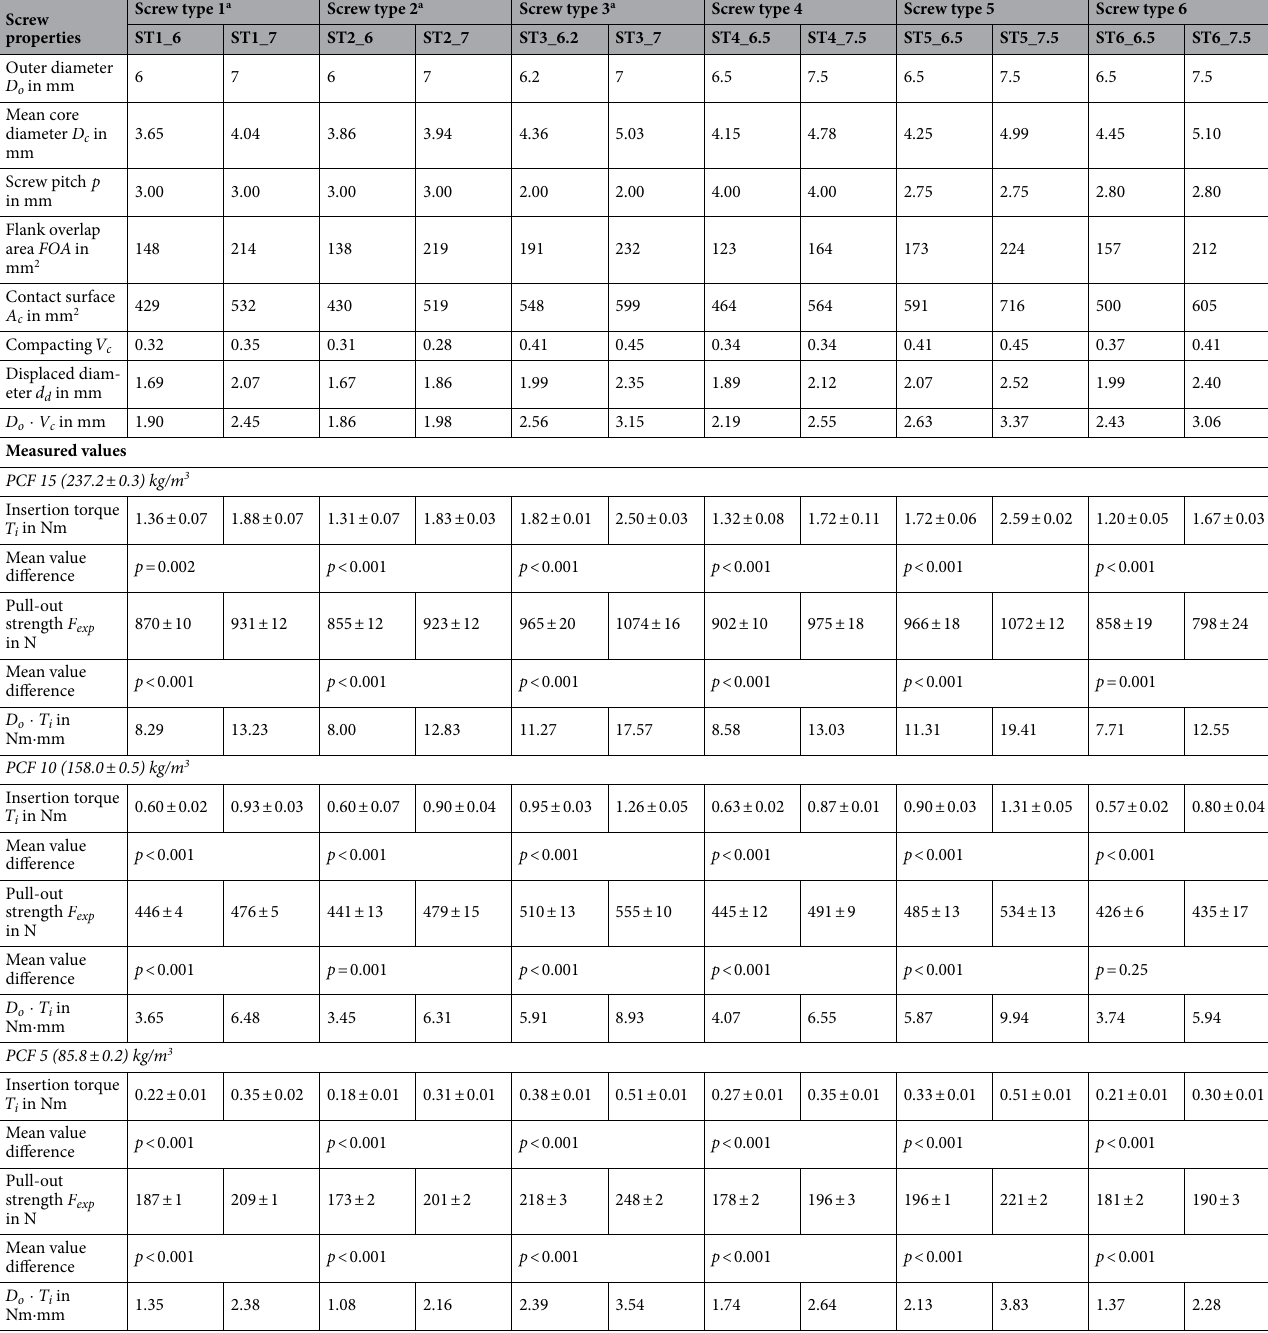
Table 2. Screw properties and measured values (mean value ± one standard deviation) including screw characteristics: outer diameter, flank overlap area, contact surface, compacting, displaced diameter, insertion torque, D o · V c and D o · T i . a These screws have a double thread, therefore the thread pitch here corresponds to the distance between two thread